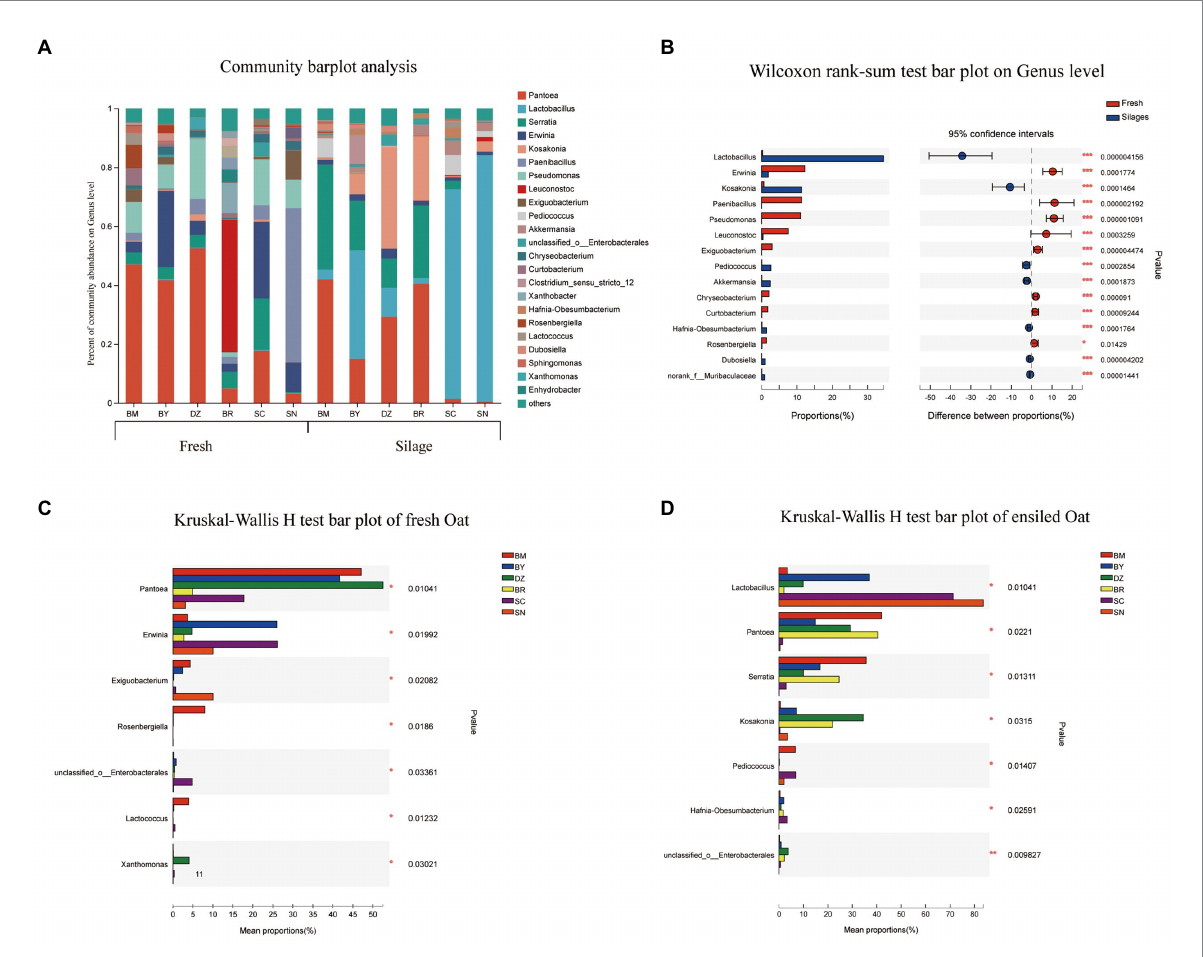
FIGURE 3 Bacterial community composition of fresh and ensiled oat along the elevation gradient on the Tibetan Plateau. (A) The bar plots of bacterial community composition of fresh and ensiled oat at the genus level. (B) Extended error bar plot showing the most abundant Bacterial genus that had significant differences between fresh and ensiled oat. Positive differences in mean relative abundance indicate the Bacterial genus overrepresented in fresh oat, while negative differences indicate greater abundance in oat silages. (C) Relative abundances of bacterial genera showed significant differences among fresh oat. A one-way ANOVA was used to evaluate the significance of differences between the indicated groups. * p < 0.05,** p < 0.01,*** p < 0.001. (D) Relative abundances of bacterial genera showed significant differences among oat silages. A one-way ANOVA was used to evaluate the significance of differences between the indicated groups. * p < 0.05,** p < 0.01,*** p <